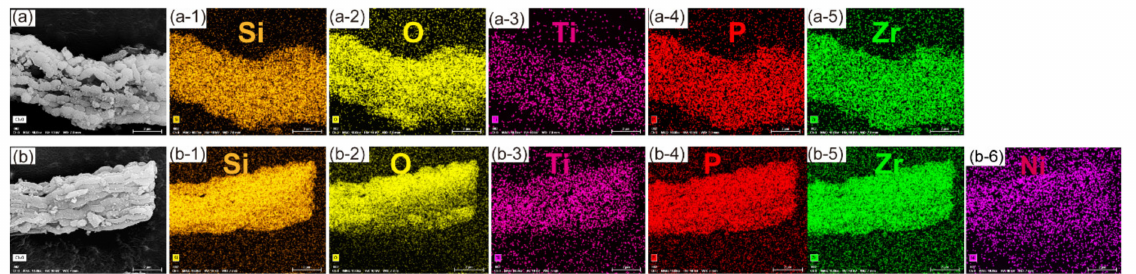
Figure 6. SEM images and EDS element-mappings of ( a ) the pristine adsorbent, ( a-1 ) Si element distribution, ( a-2 ) O element distribution, ( a-3 ) Ti element distribution, ( a-4 ) P element distribution, ( a-5 ) Zr element distribution and ( b ) the adsorbed adsorbent, ( b-1 ) Si element distribution, ( b-2 ) O element distribution, ( b-3 ) Ti element distribution, ( b-4 ) P element distribution, ( b-5 ) Zr element distribution, ( b-6 ) Ni element distribution.